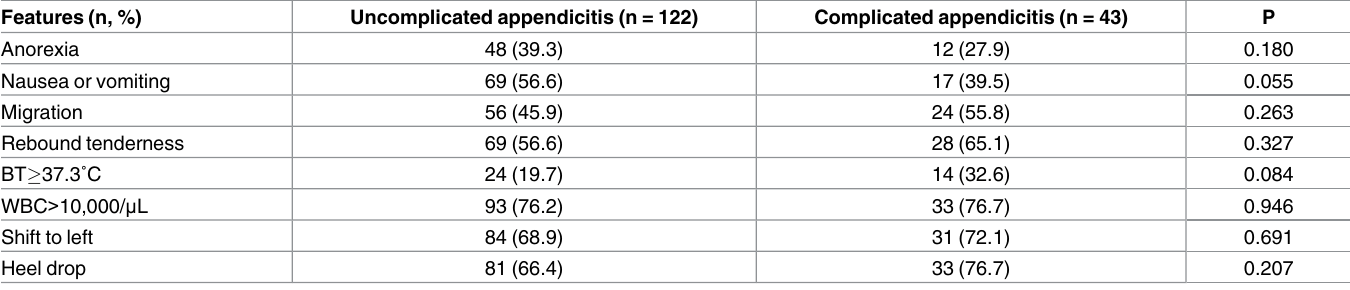
Table 2. Features of the Alvarado score and heel drop test in assessing acute appendicitis. Features (n,